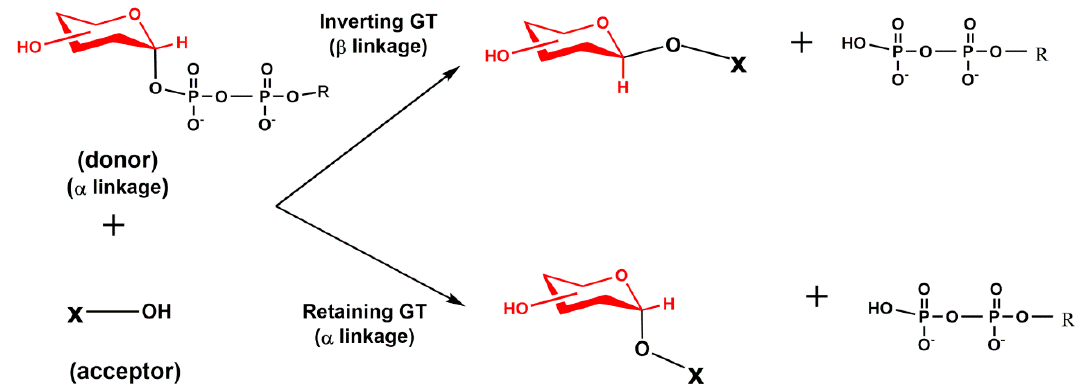
Figure 6. Schematic diagram of inverting and retaining reactions catalyzed by glycosyltransferases. The transferred saccharide residue is shown in red.